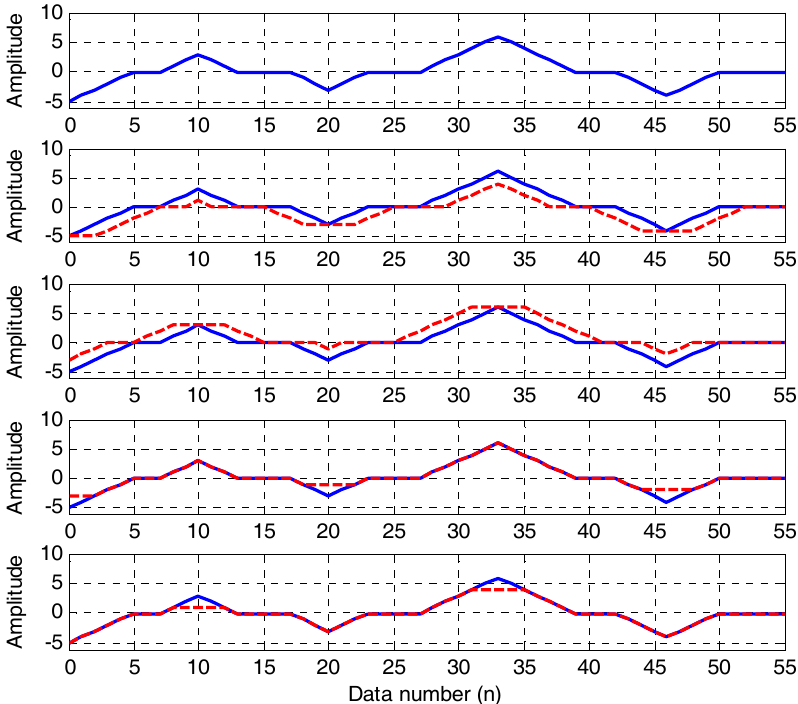
Figure 7. Illustration of four MM operators (second to fifth row).